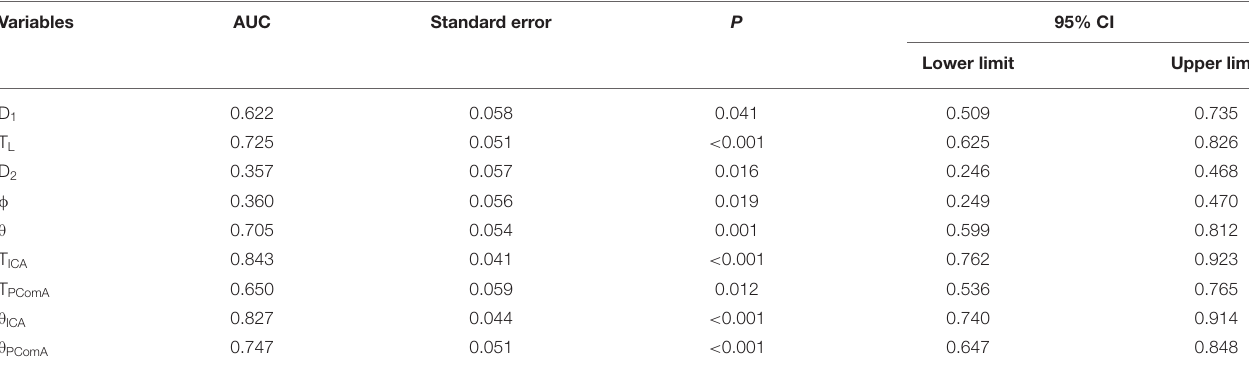
TABLE 3 | The receiver operating characteristic (ROC) curve analysis of morphological parameters for the diagnosing presence of PComA aneurysms. Variables AUC Standard error P 95% CI